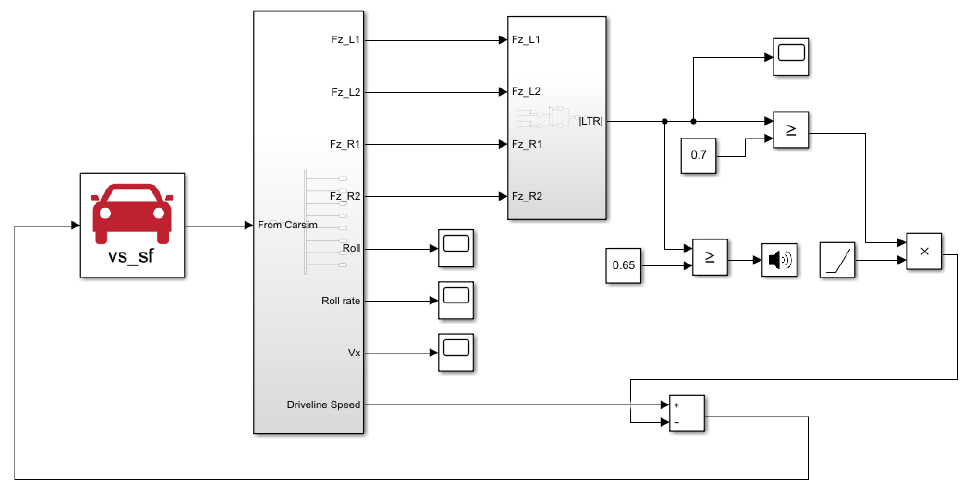
Figure 4. Simulink simulation model.